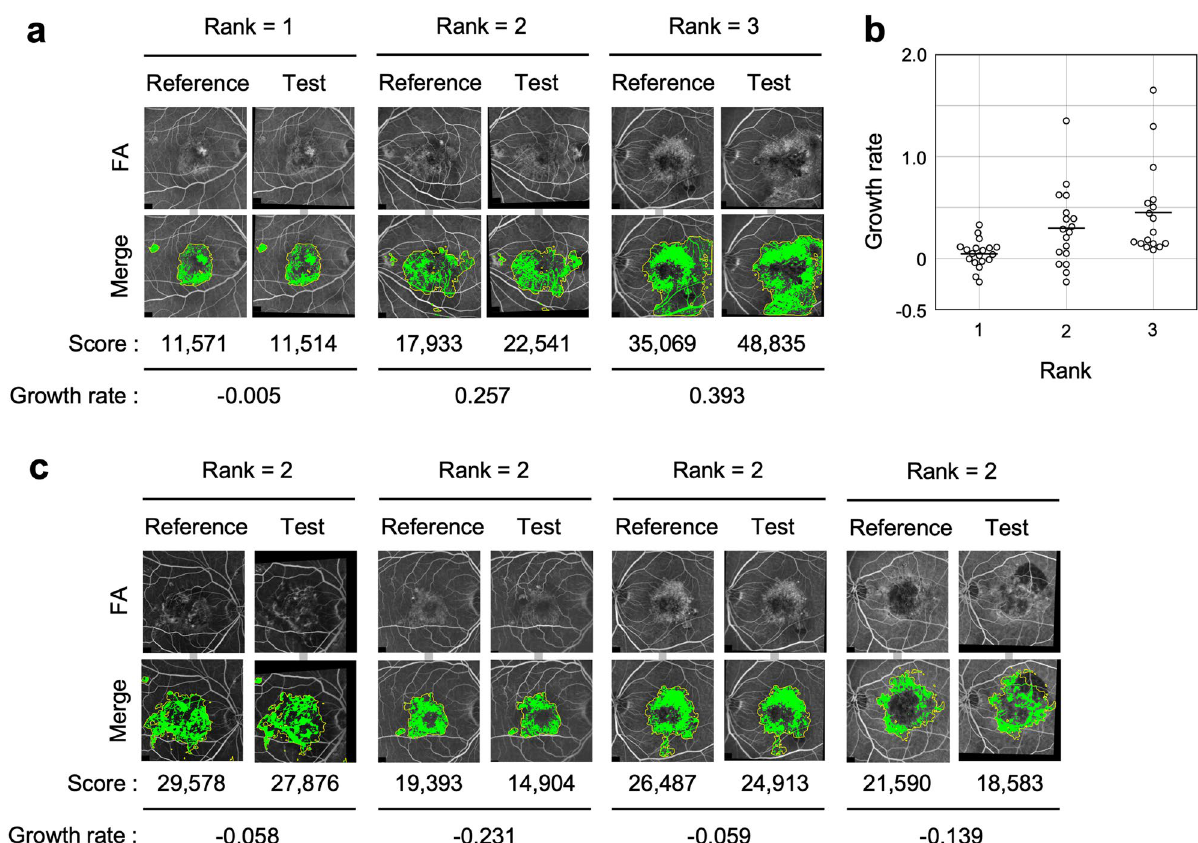
Figure 5. Comparison of Score change with a specialized ophthalmologist. ( a ) Representative pair of images for each rank as unanimously determined by two specialized ophthalmologists. Rank 1: approximately the same; Rank 2: slightly worse; Rank 3: much worse. Upper: Pairs of FA images aligned and brightness-corrected by image processing. Lower: Output binary images. yellow frames represent Abnormal regions (Mask regions) predicted by U-net. Green areas represent Hyperfluorescent areas. The Score represents the sum of the pixel numbers of the Hyperfluorescent area in the binarized image within the Mask area. The Growth rate represents the (Test score—Reference score)/Reference score. ( b ) The scatter and box plot graph shows the Growth rate in the three ranks of changes in the disease status that were judged by two specialized ophthalmologists. The black bars represent averages. ( c ) Four discrepant cases in Rank 2 where the value of the Growth rate was less than 0. Upper and Lower: represent the same as ( a